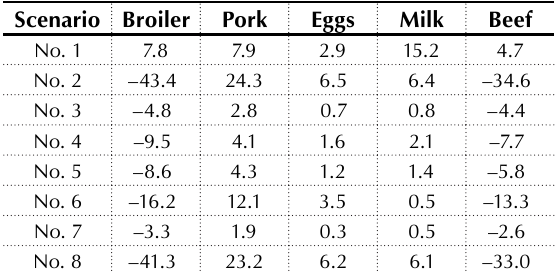
Table 2. Calculated changes (%) in animal food